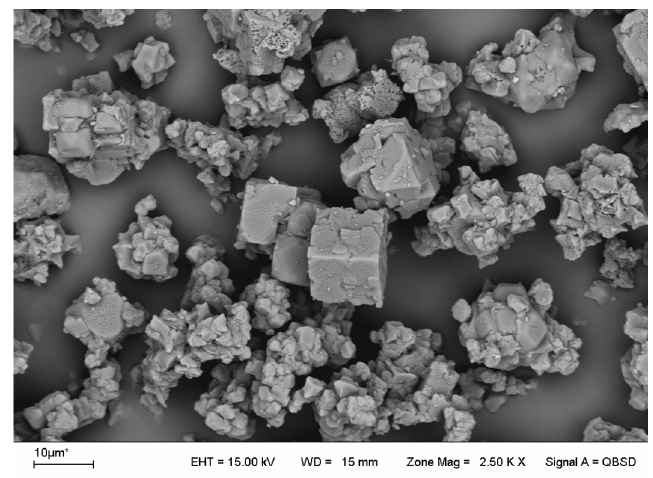
Figure 10. SEM micrograph of the precipitated LiF.